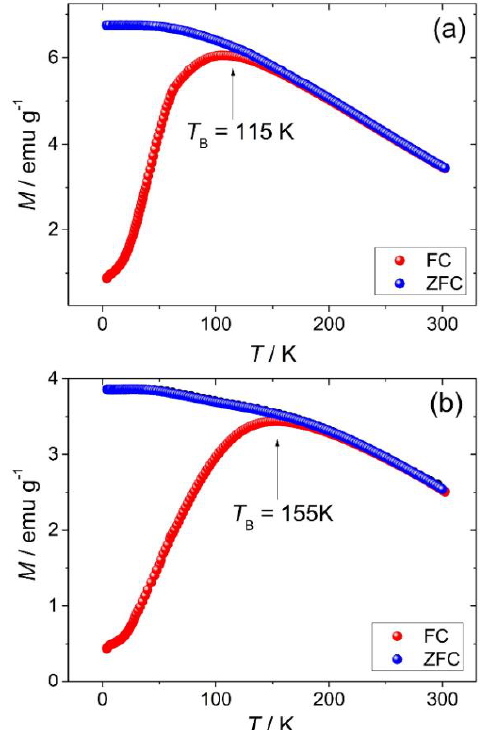
Figure 7. Magnetisation curves measured in zero-field cooling (ZFC, blue) and field cooling (FC, red) mode with H FC = 100 Oe for Fe substituted γ -Ga 2 O 3 ( a ) Fe:Ga 1:1 and ( b ) Fe:Ga 3:7. T B indicates the blocking temperatures.